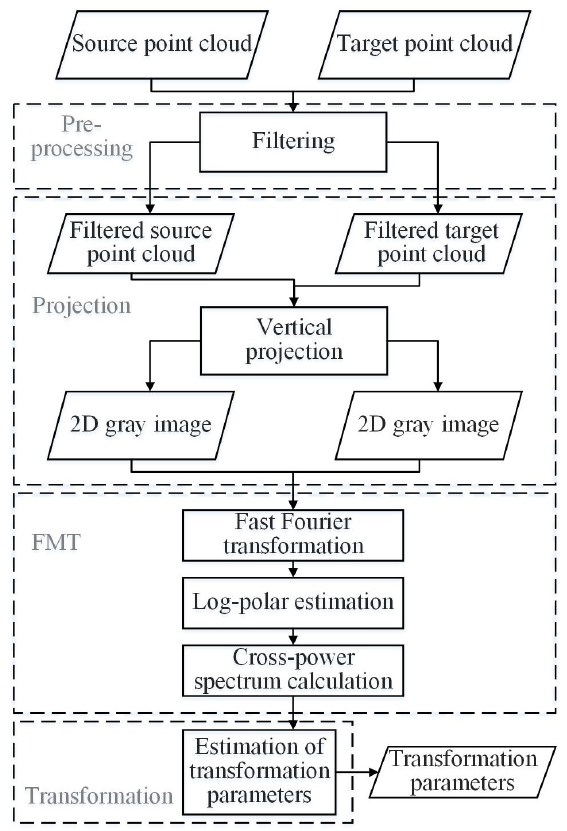
Figure 1. Workflow of the proposed fast coarse registration strategy.